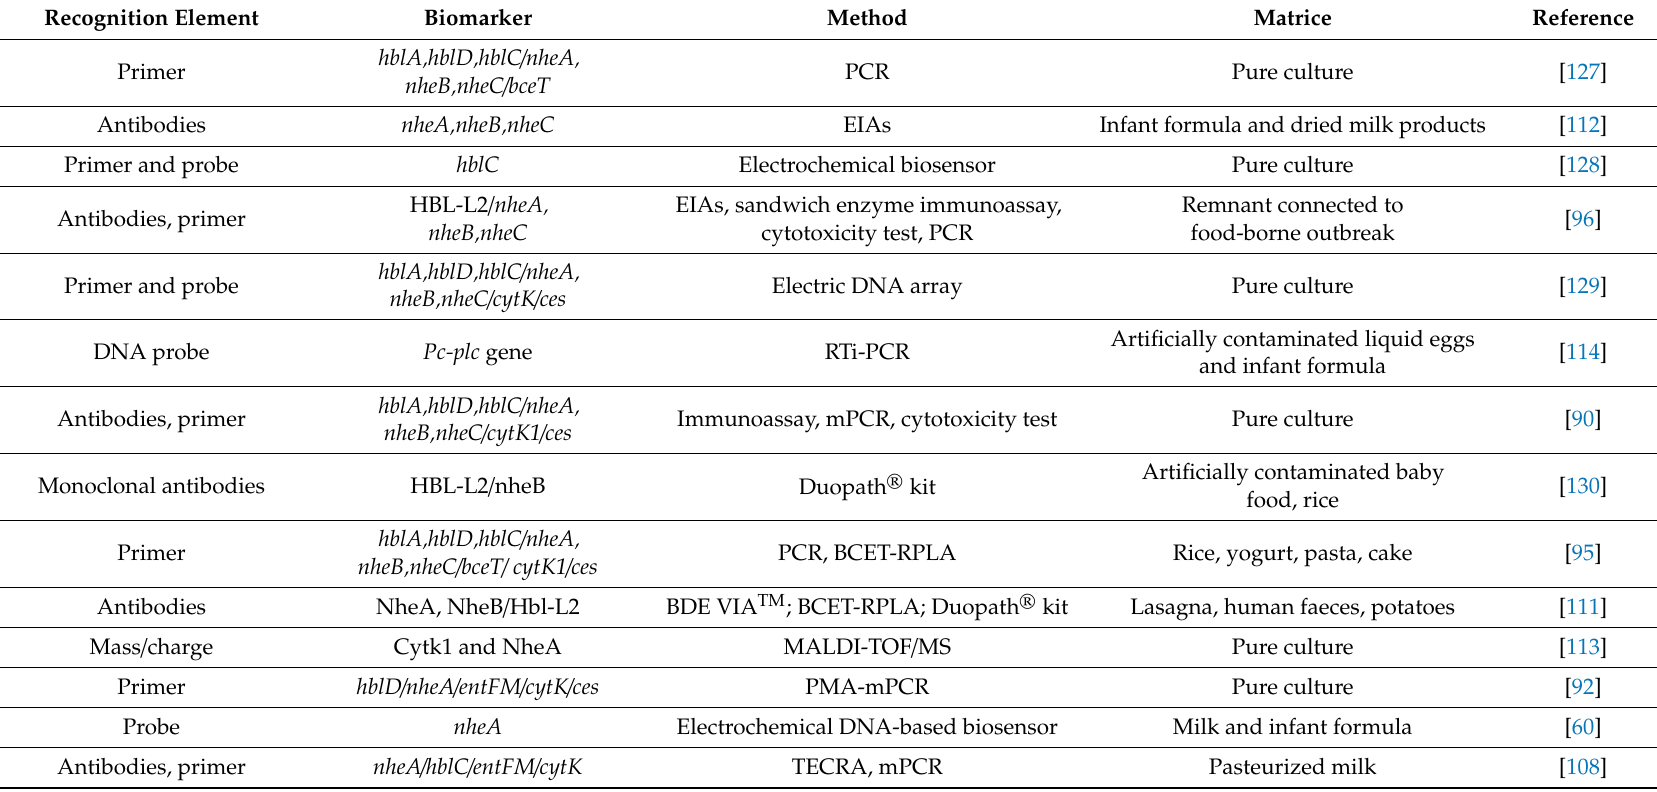
Table 3. Detection method for B. cereus enterotoxins and other pathogenic